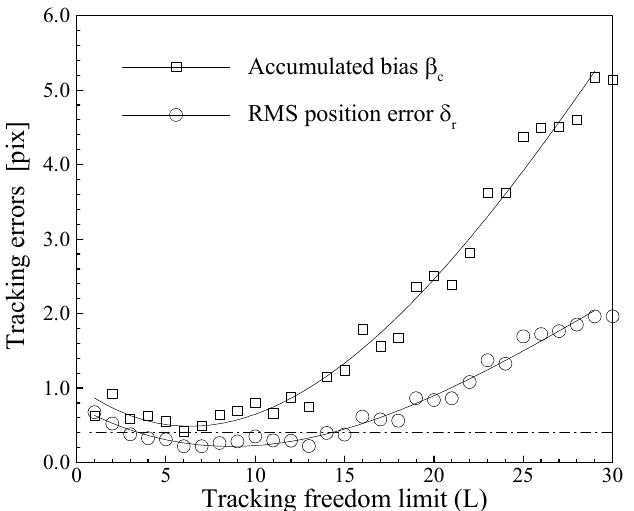
Figure 6. Tracking error distributions before the highest peaks for synthetic image pattern of d = 6 0